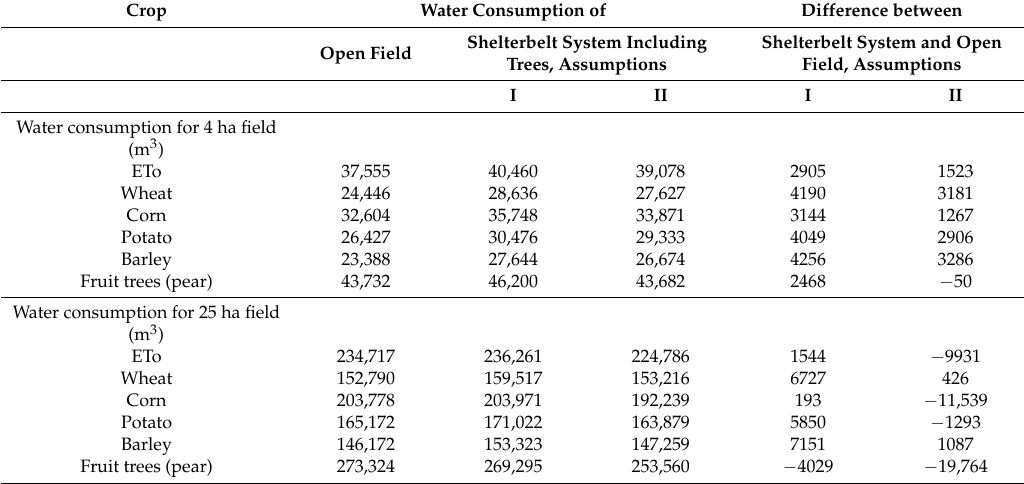
Table 5. Water consumption of open field conditions (crop without any shelterbelt) and shelterbelt system (crops and trees) for 4 ha and 25 ha field plot, respectively. Negative differences indicate that the whole shelterbelt system consumes less water than the crop without shelterbelt. Crop Water Consumption of Difference between Shelterbelt System Including Shelterbelt System and Open Open Field Trees, Assumptions Field, Assumptions I II I